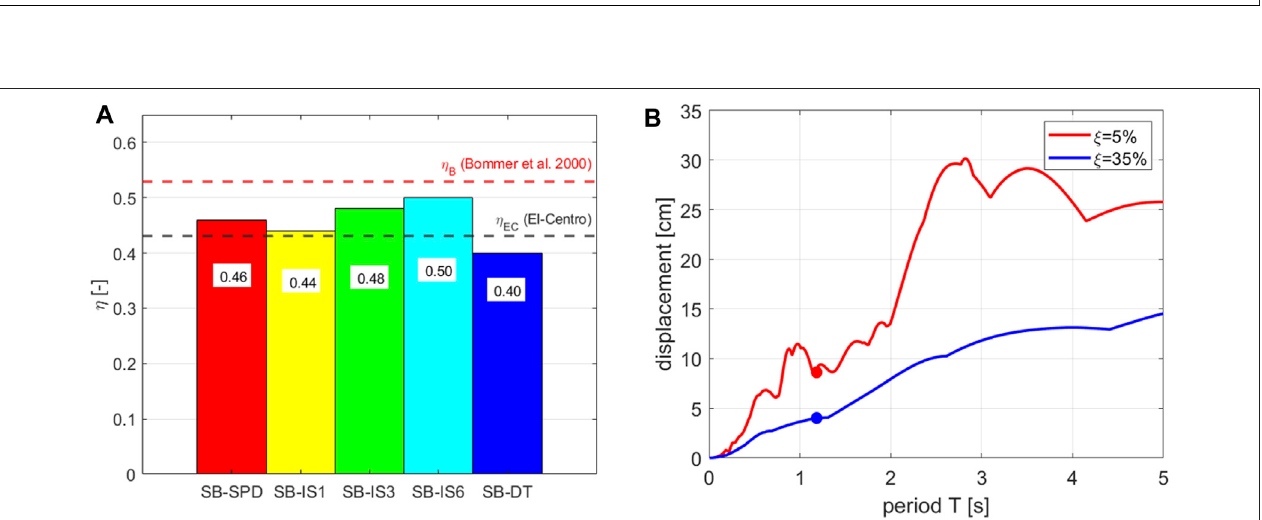
FIGURE 9 | (A) Histogram of the damping reduction factors of the ID for the SB systems. (B) Displacement spectra for El-Centro ground motion.